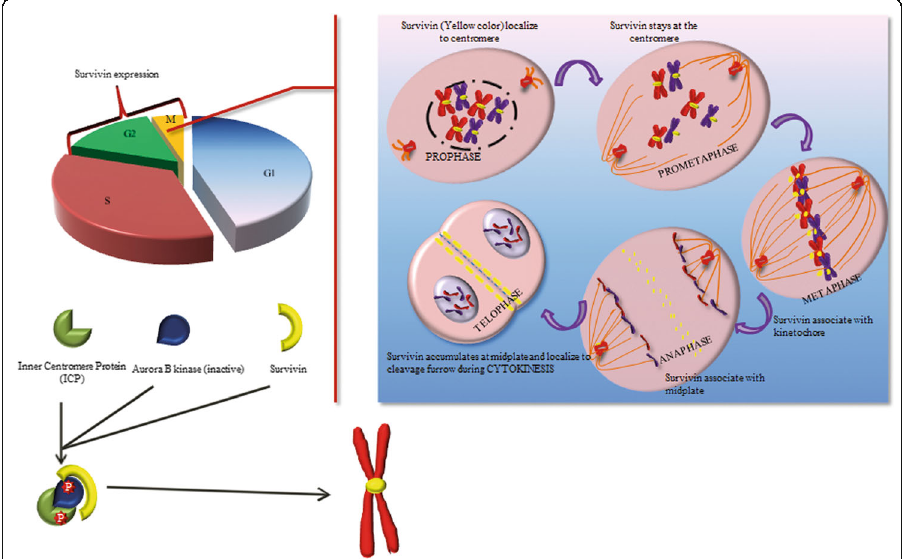
Fig. 1 Role of survivin in cell cycle. In association with Aurora B and ICP, survivin forms a chromosomal passenger complex that bind to their target sites including centromere, midplate and cleavage furrow, where it regulates proper chromosome segregation and